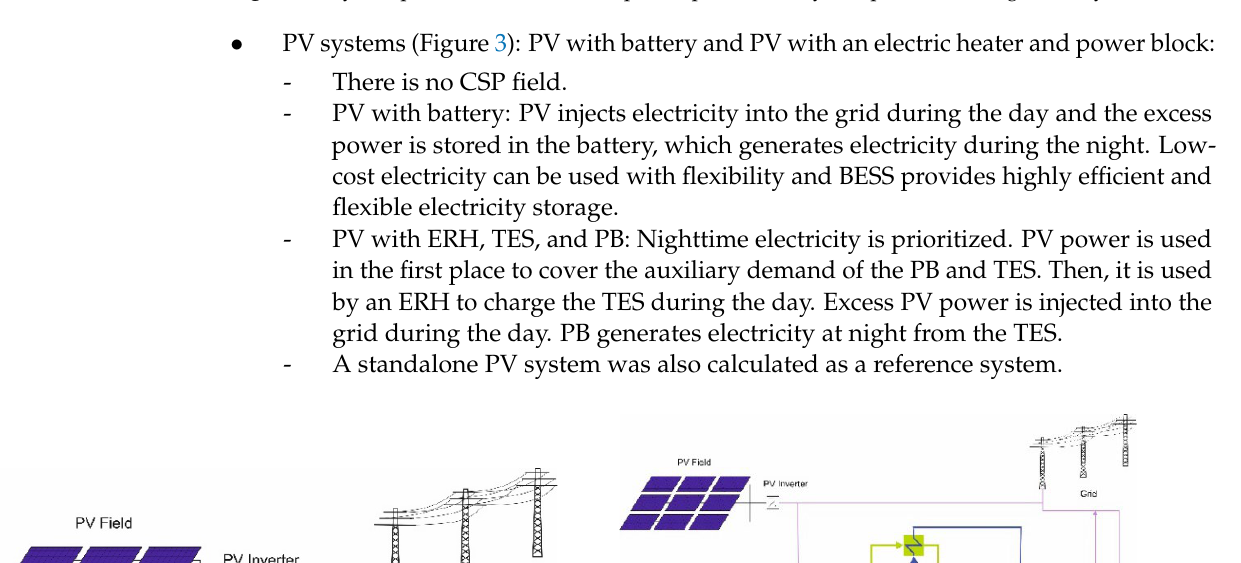
Figure 2. Hybrid photovoltaic (PV)-CSP power plants: ( a ) Hybrid parabolic trough; ( b ) Hybrid tower.